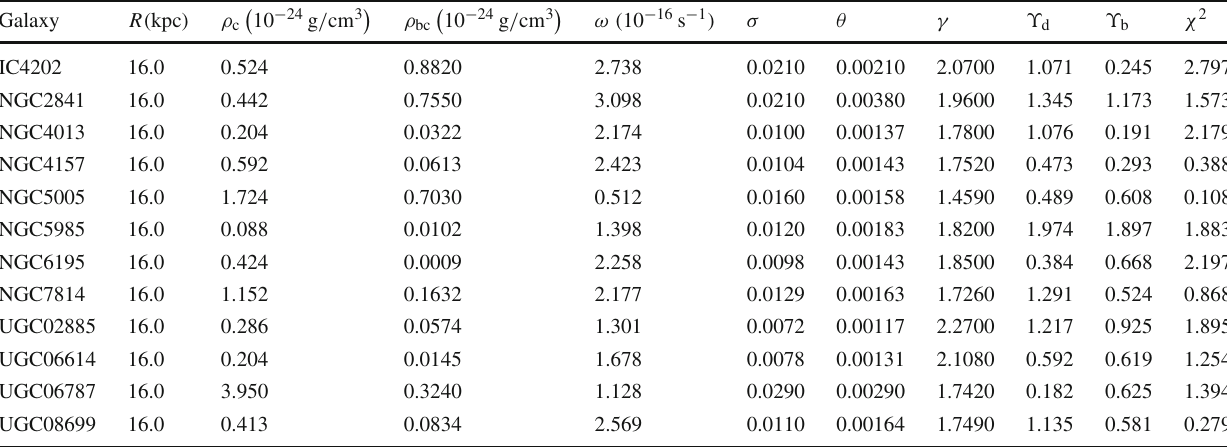
Table 4 Optimal parameters for galaxies with bulge velocity, and constant static radius R